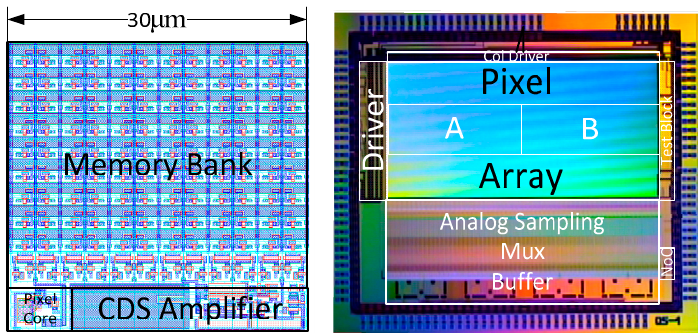
Figure 11. The Type A pixel layout and the chip microphotograph.